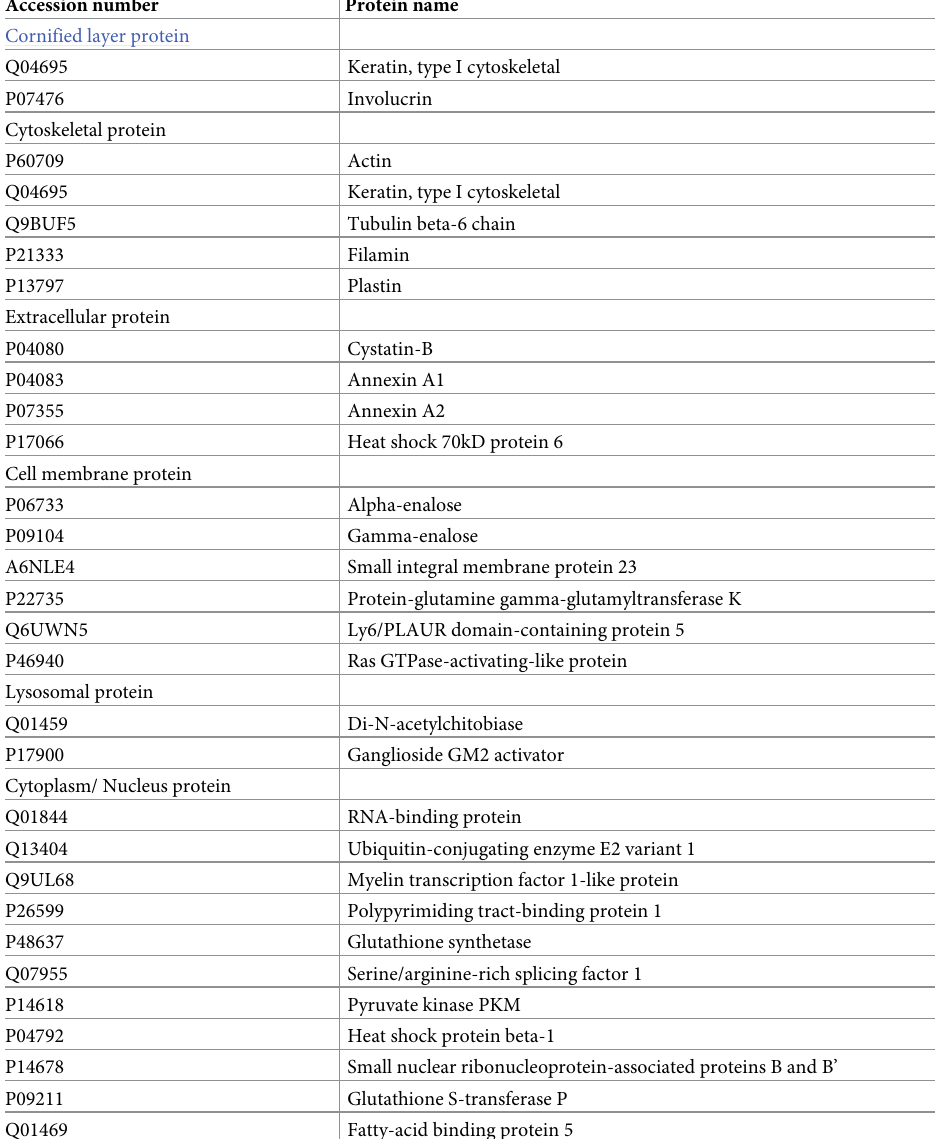
Table 1. Substrates of SjCB2 detected in the cultivated human